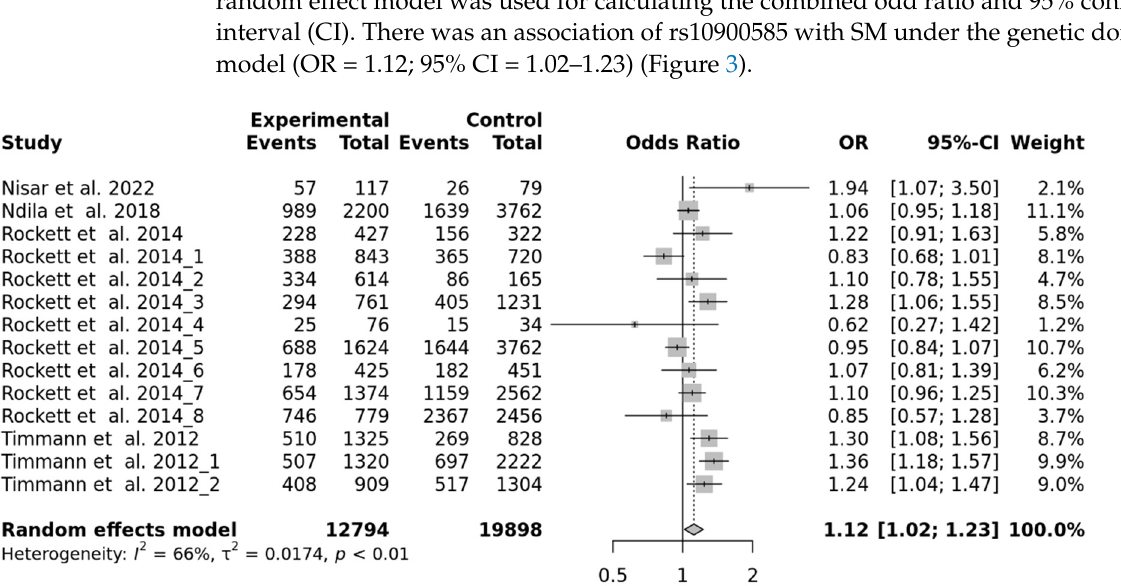
Table 2. Association of ATP2B4 SNPs with severe malaria in the Senegalese population-based study. SNP